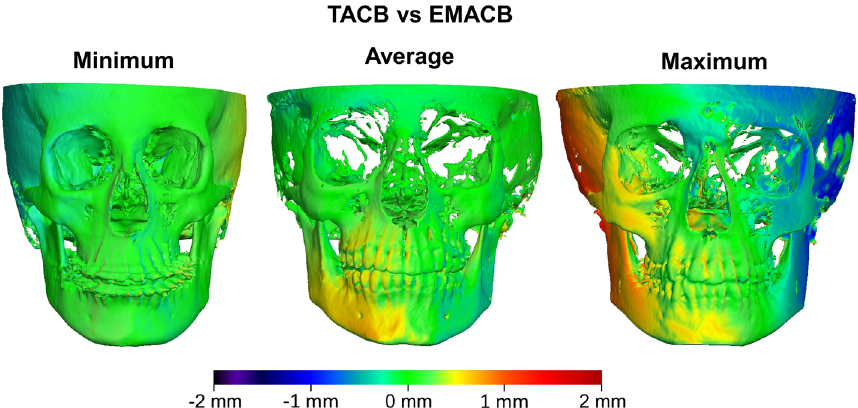
Figure 7. Color coded distance maps showing the differences of T1 surfaces obtained from T0–T1 TACB and EMACB voxel-based superimpositions, with the T0 surface held constant as a reference. The samples that presented the least ( left ), average ( middle ), and largest ( right ) absolute distances of the EMACB from the TACB T1 surface, on the seven measurement areas, are shown.